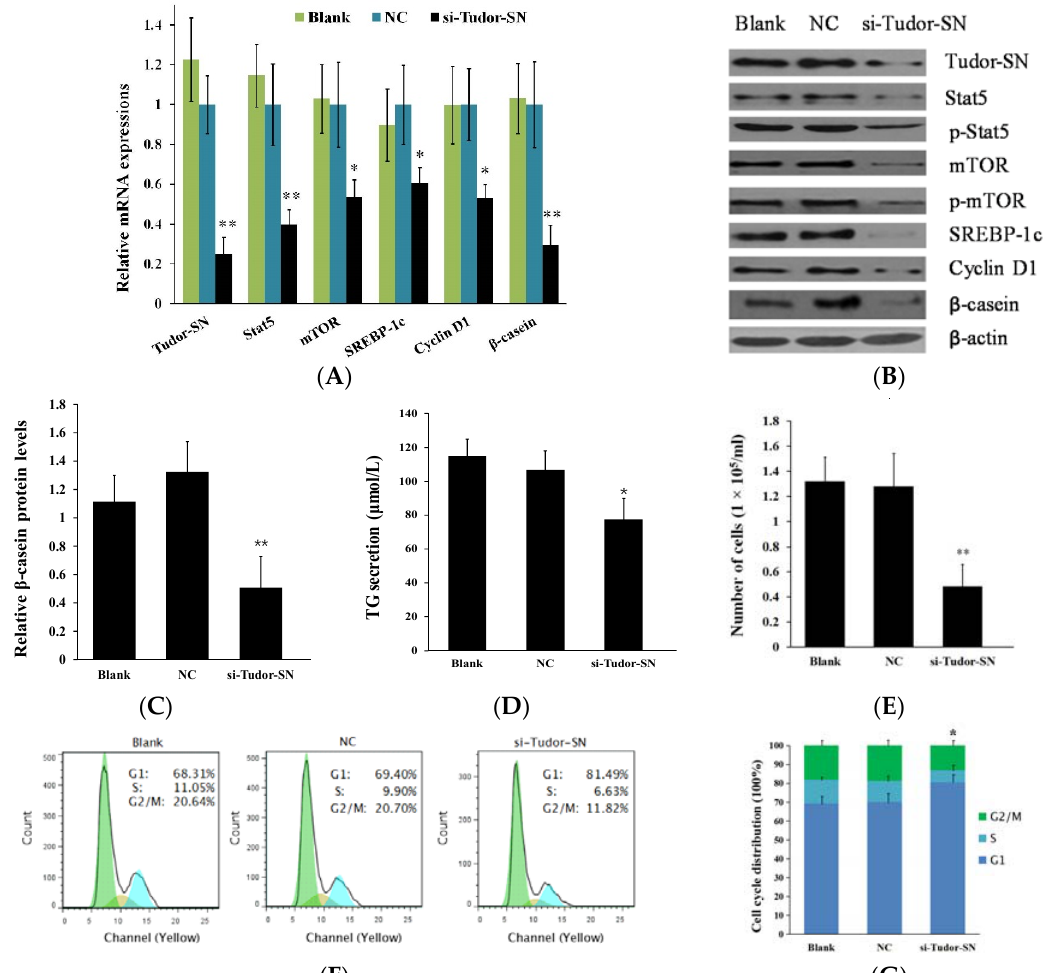
Figure 2. Gene silencing of Tudor ‐ SN downregulates cell signaling pathways leading to milk synthesis and proliferation of BMEC. Cells were divided into three groups: Blank, untransfected cells; NC, cells transfected with a scrambled control RNA; and si ‐ Tudor ‐ SN, cells transfected with a siRNA targeting Tudor ‐ SN. Cells were detected 24 h after transfection. ( A ) Indicated mRNA levels were detected by q RT ‐ PCR and normalized to β‐ actin; ( B ) Expression of the indicated proteins were analyzed by western blotting analysis, β‐ actin was used as a loading control; ( C ) The relative β‐ casein contents were calculated by the β‐ casein/ β‐ actin relative fold change of gray scale scanning of western blotting results; ( D ) The TG contents in the culture supernatants of BMEC were measured by the TG GPO ‐ POD assay Kit; ( E ) Cell numbers were determined using a model DT CASY cell counter; ( F , G ) Cell cycle transition was determined by flow cytometry using a FACS Calibur. Representative histograms ( F ) and quantitation of three independent experiments ( G ) were shown, the histogram demonstrated the percentage of the cells in each phases. Blue, light blue, and green columns shows percents of cells in the G1, S, G2/M phases respectively. Data represent the mean ± standard deviation (SD). * p < 0.05, ** p < 0.01, treatment versus controls (NC) (Figure 1A,C,D,E), n = 3.